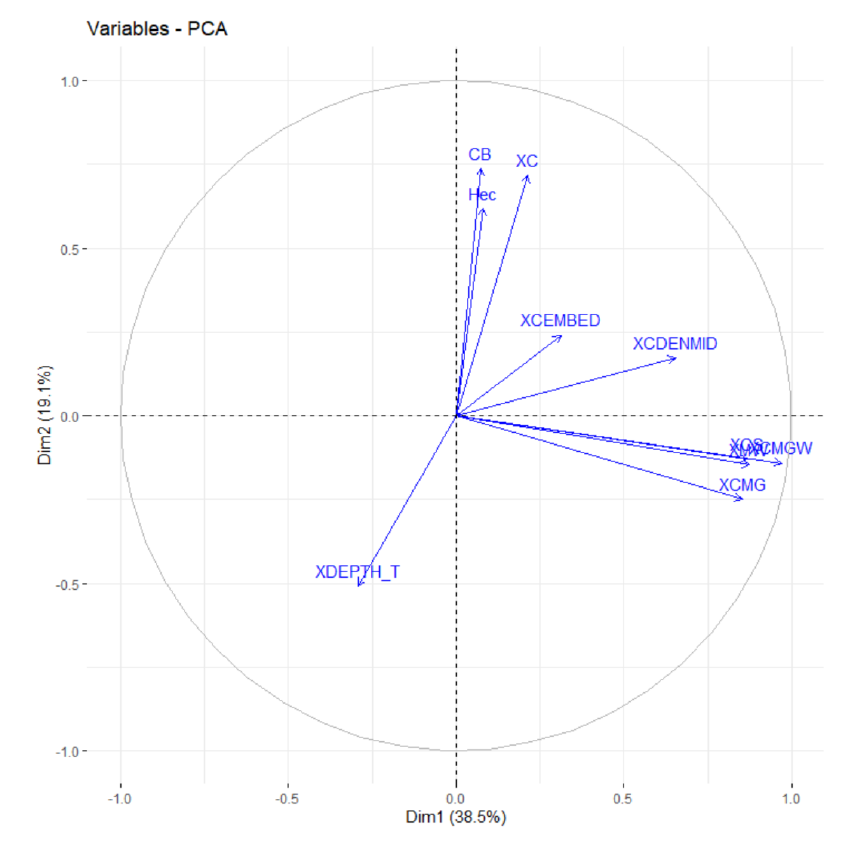
Figure 3. Principal component analysis (PCA) based on environmental variables of sampled streams. Wood debris volume (XC); Mean canopy coverage of the channel (XCDENMID); Mean canopy cover of small trees (XCS); Mean canopy cover of woody understory (XMW); Mean Canopy Coverage (XXC); Mean total canopy cover (XCMG), Mean coverage of woody canopy (XCMGW); Mean depth thalweg (XDEPTH_T); Mean Channel Immersion (XCEMBED); Proportion of primary vegetation (by microbasin) (CB); Total size of the microbasins